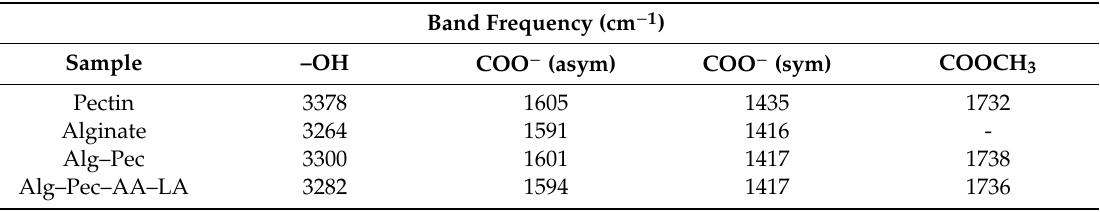
Table 2. FTIR-ATR main vibrational frequencies of pectin–alginate based